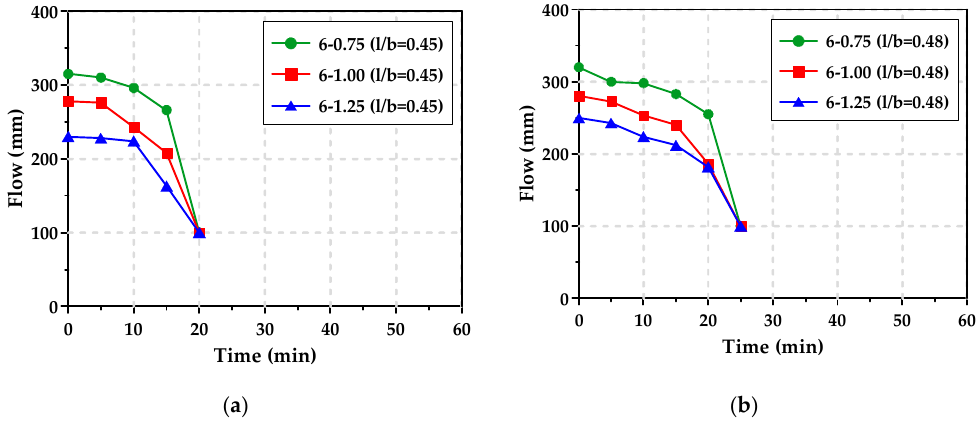
Figure 6. Mini slump curves of AAS pastes: ( a ) l/b = 0.45, ( b ) l/b = 0.48.